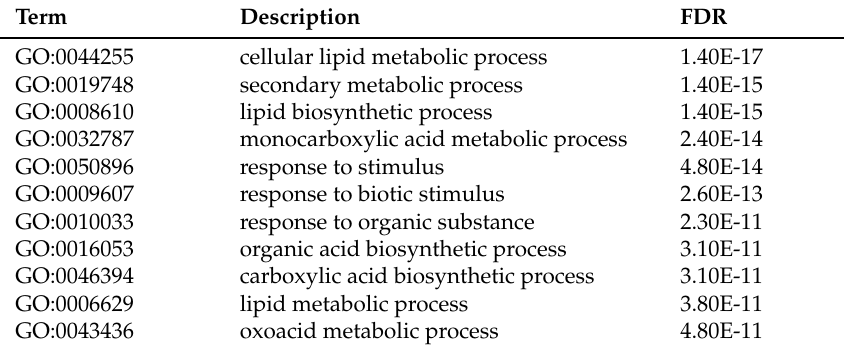
Table 1. Top 20 Gene Ontology (GO) biological process categories enriched in MeJA treated Medicago suspension cells. Based on significance of enrichment (False Discovery Rate (FDR) < 0.05) in genes expressed ě 10-fold in 24 h MeJA treated cell suspension relative to control treatment at the same time-point. Data sourced from MtGEA [64–66,68] and analyzed via agriGO